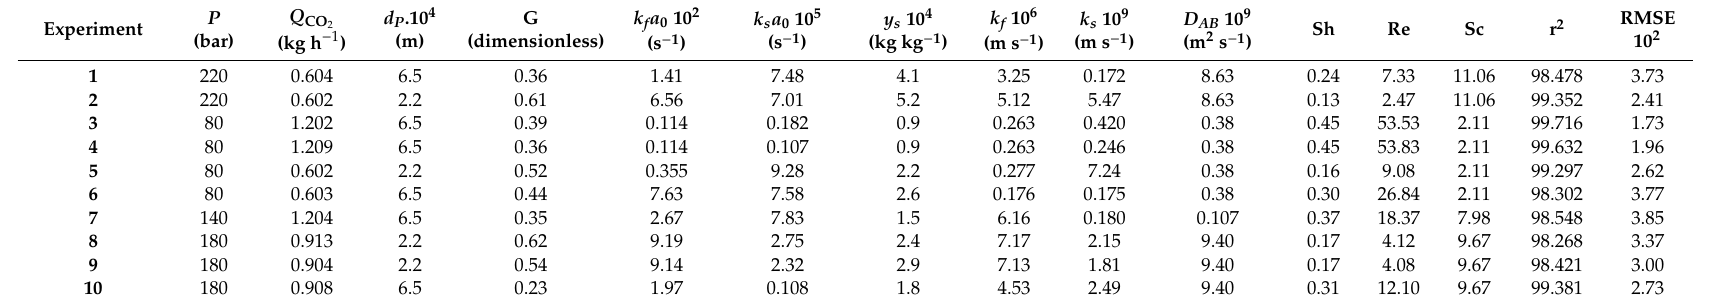
Table A2. Operating conditions estimated TWO parameters from best fitting and modeling errors used by Lito.